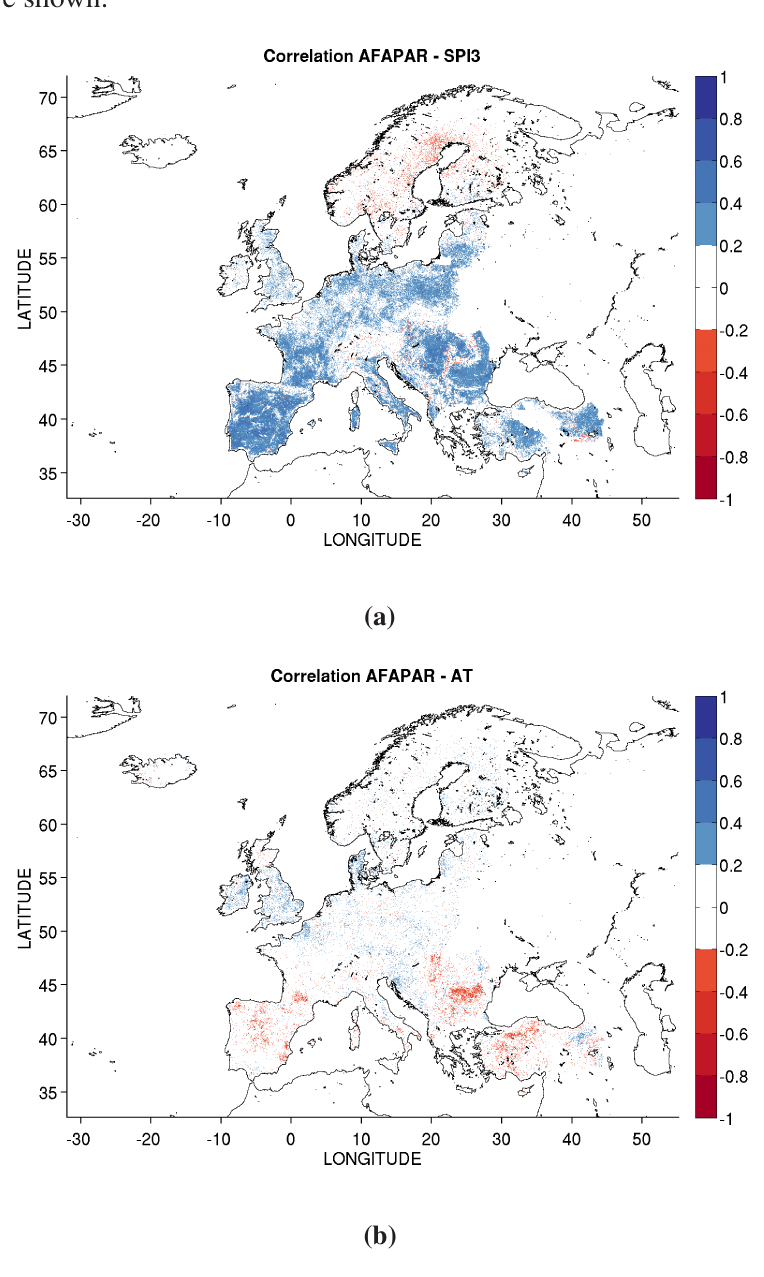
Figure 4. Maximum (absolute) cross-correlation coefficient between anomalies of FAPAR (AFAPAR) and ( a ) rainfall (SPI-3) and ( b ) temperature (AT). Only significant ( p = 0.05) correlations are